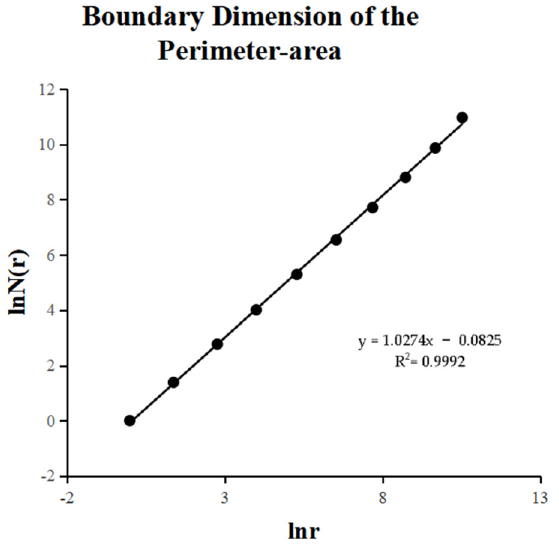
Figure 6. Bilogarithmic graph of boundary dimension estimated by circumference–area model for Block 15.